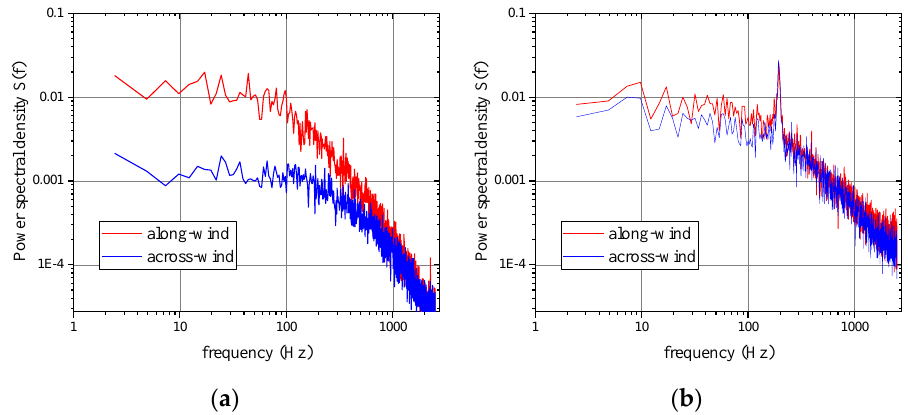
Figure 19. Comparison of the power density spectrum (uniform inflow, Re: 0.8 × 10 6 ). ( a ) α = 8.4°, baseline airfoil; ( b ) α = 8.4°, Gurney flap 9 mm × 4.5 mm.